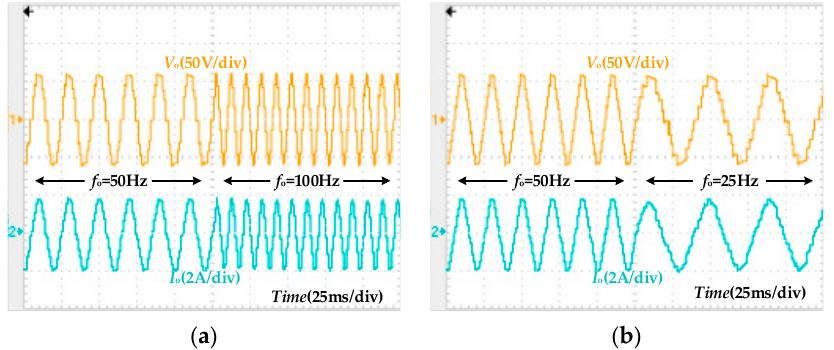
Figure 21. Experimental results when f o changes. ( a ) f o changes from 50 Hz to 100 Hz. ( b ) f o changes from 50 Hz to 25 Hz.